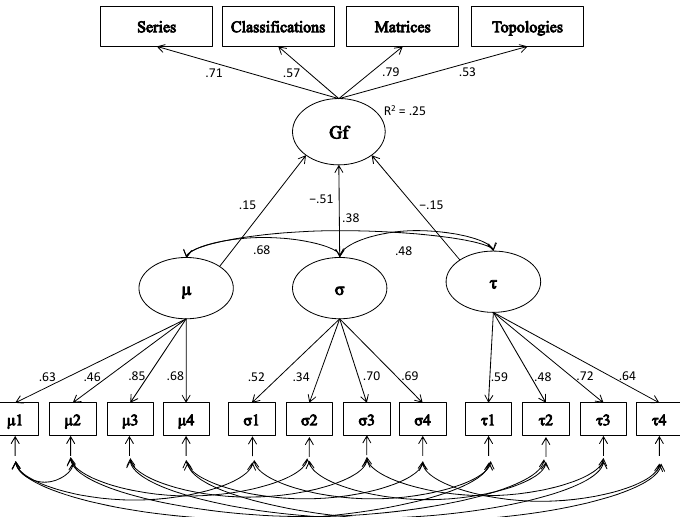
Figure 1. Simplified graphic of the prediction of fluid intelligence (gf) with the eGM parameters μ (represents the mean of the Gaussian part), σ (represents the standard deviation of the Gaussian part) and τ (represents the standard deviation of the exponential part).